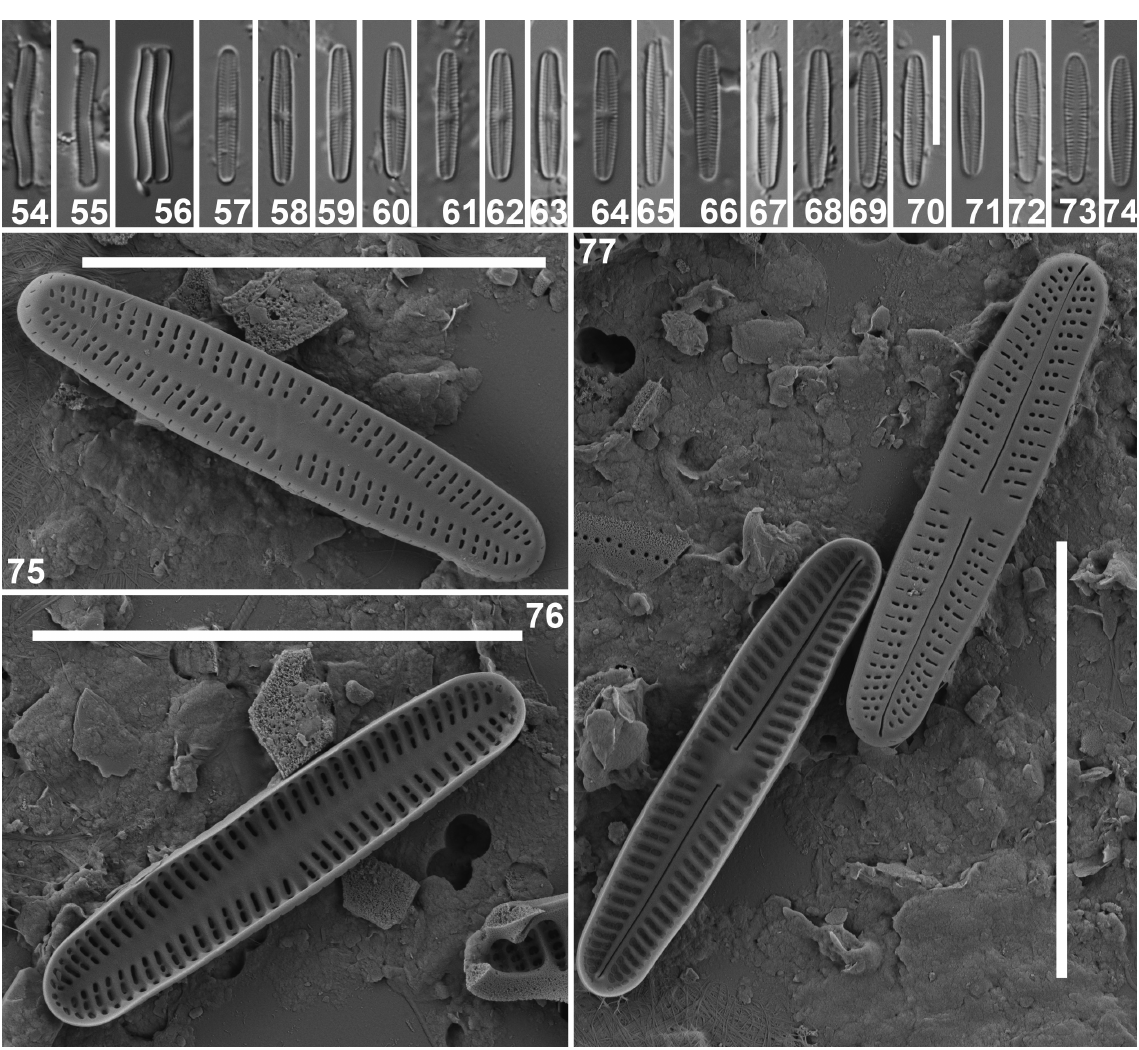
Figs 54-77. Achnanthidium lailae Van de Vijver. Light and scanning electron micrographs of a population on Clearwater Mesa (James Ross Island). 54-56 . LM views of some frustules in girdle view. 57-64 . LM views of raphe valves. 65-74 . LM views of rapheless valves. 75 . SEM external view of an entire rapheless valve. 76 . SEM internal view of an entire rapheless valve. 77 . SEM external (right) and internal (left) view of an entire raphe valve. Scale bars represent 10